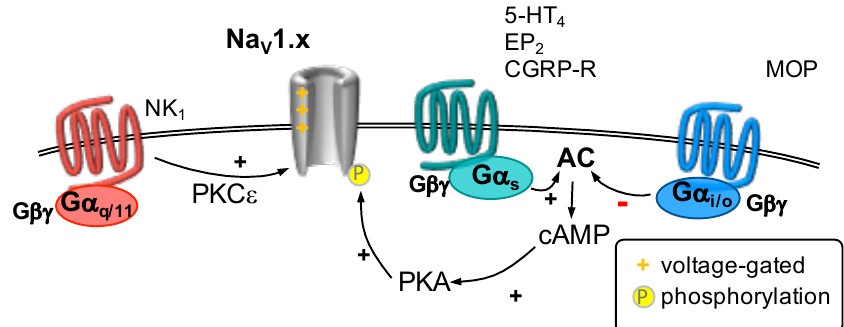
Figure 5. Na V 1.x channels are activated by depolarizing voltages (as indicated). Activation of G α s -coupled receptors stimulates adenylyl cyclase (AC) activity ( center ). Subsequently, cyclic adenosine monophosphate (cAMP) is formed, which activates protein kinase A (PKA). PKA-mediated phosphorylation of voltage-gated Na + channels increases their currents. By contrast, activation of G α i / o -coupled receptors ( right ) decreases AC activity and counteracts G α s -mediated current increases. Activation of a G α q /11 -receptor ( left )was shown to increase Na V -mediated currents involving protein kinase C (cid:101) (PKC (cid:101)